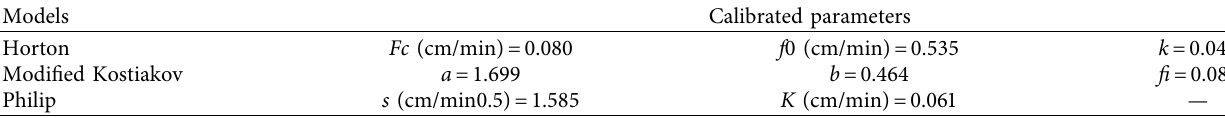
Table 2: Parameters obtained for the conventional infiltration models.